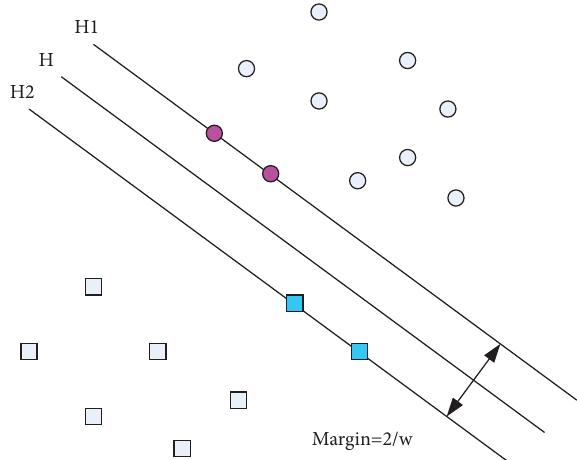
Figure 6: Support vector